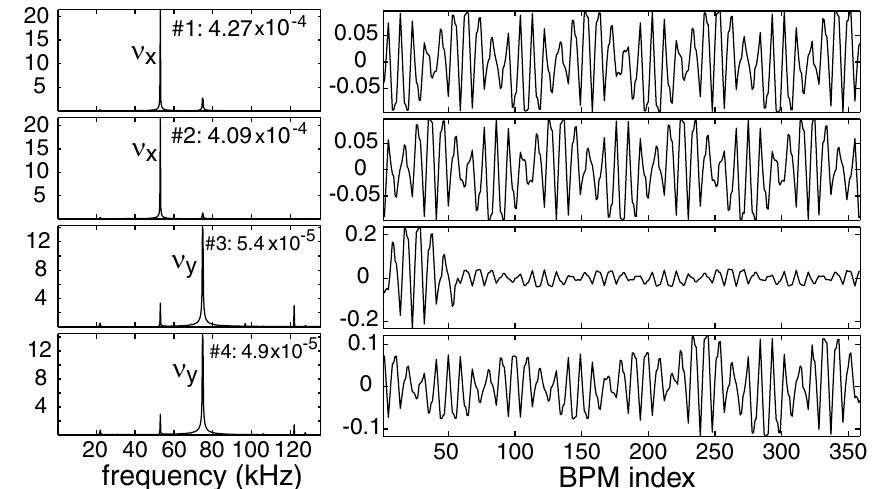
FIG. 1. Fourier spectra of the temporal vectors (left) and the spatial vectors (right) of the SVD modes. Mode numbers and singular values are shown in the upper right